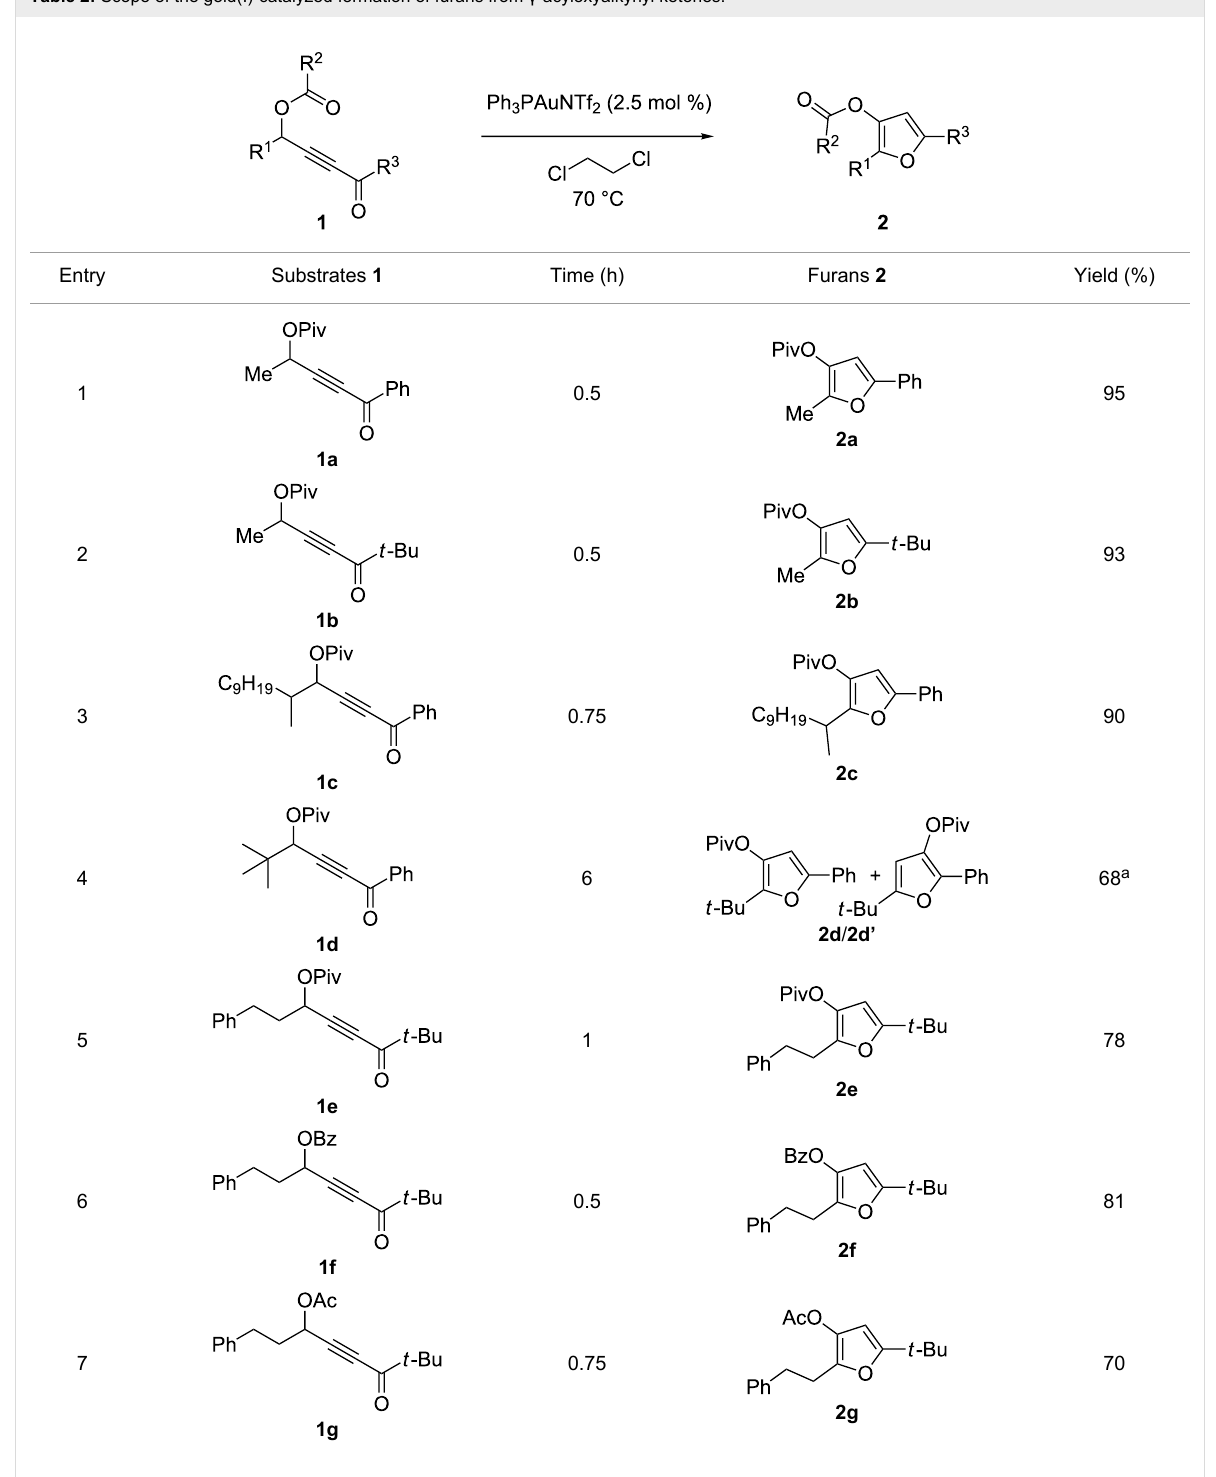
Table 2: Scope of the gold(I)-catalyzed formation of furans from γ -acyloxyalkynyl